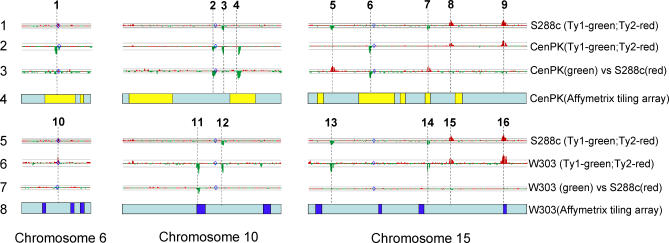
Comparison of Full-Length Ty1 and Ty2 Elements on Chromosomes VI, X, and XV in Strains S288c, CEN.PK, and W303Rows 1, 2, 3, 5, 6, and 7 are based on transposon extraction data from Agilent yeast whole genome microarrays. Rows 4 and 8 correspond to Affymetrix tiling arrays probed with either CEN.PK DNA or W303 genomic DNA. For rows 1, 2, 5, and 6, digested genomic DNA as noted was extracted with either Ty1-specific or Ty2-specific sets of probes. For rows 3 and 7, digested genomic DNA was extracted with the set of common Ty1 and Ty2 probes. Numbers above vertical dashed lines refer to examples of transposon insertions of interest. Grey horizontal lines above and below the central line for each chromosome correspond to a 3-fold ratio of signal intensity. In rows 4 and 8, pale blue rectangles correspond to regions of CEN.PK and W303, respectively, derived from its S288c parent. In row 4, yellow rectangles correspond to regions of CEN.PK derived from its non-S288c parent. In row 8, dark blue rectangles correspond to regions of W303 derived from its non-S288c parent.